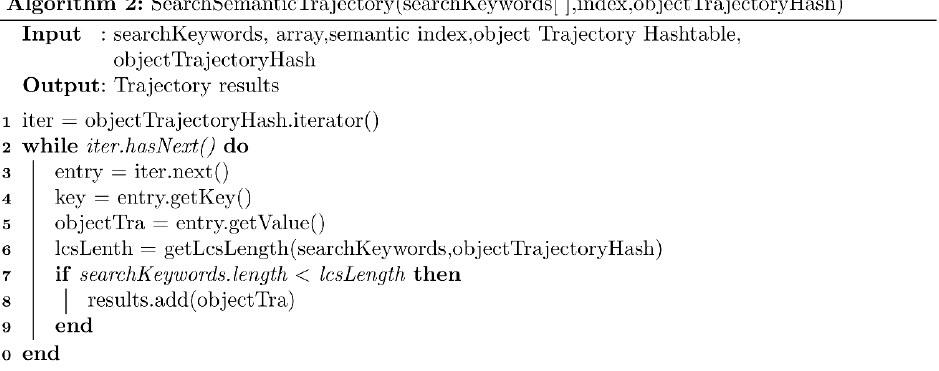
Figure 15. The semantic trajectory query algorithm.